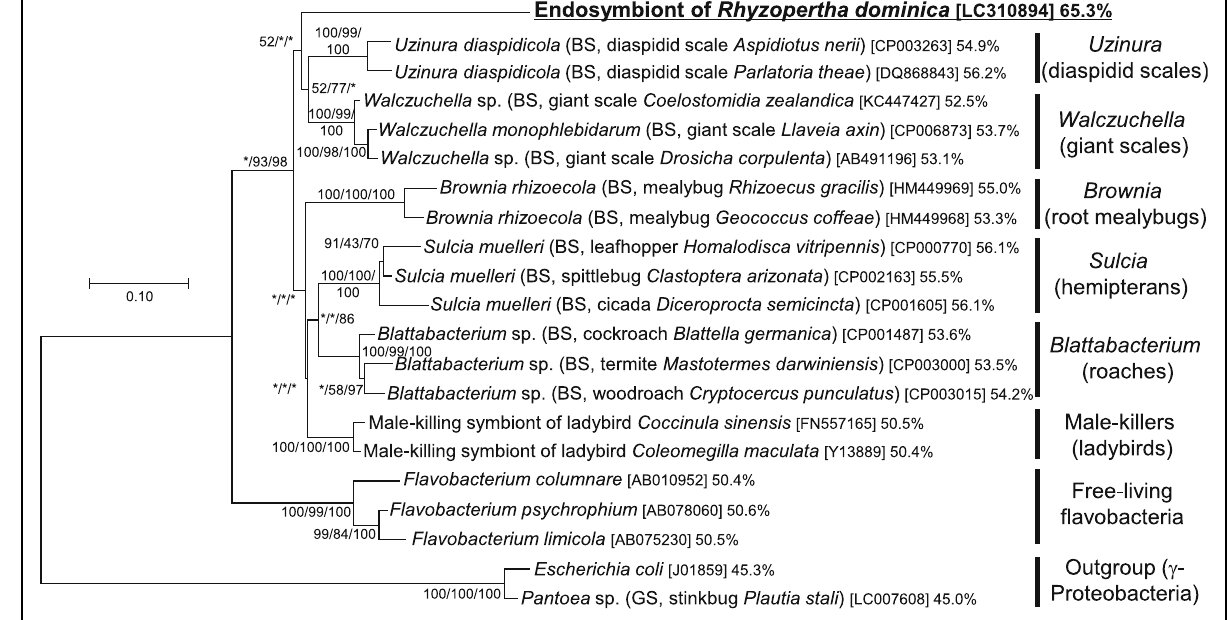
Fig. 2 Phylogenetic placement of the symbiont of R. dominica in the Bacteroidetes based on 16S rRNA gene sequences. A maximum-likelihood phylogeny inferred from 1185 aligned nucleotide sites is shown. Statistical support values for each clade are indicated in the order of bootstrap probability of the neighbor-joining analysis, bootstrap probability of the maximum-likelihood analysis, and posterior probability of the Bayesian analysis from left to right, in which asterisks indicate values less than 50%. Host-related information in parentheses, accession number in brackets, and AT-content in percentage follow each bacterial taxon. BS and GS indicate bacteriocyte symbiont and gut symbiont, respectively. Labels for each major clade are shown on the